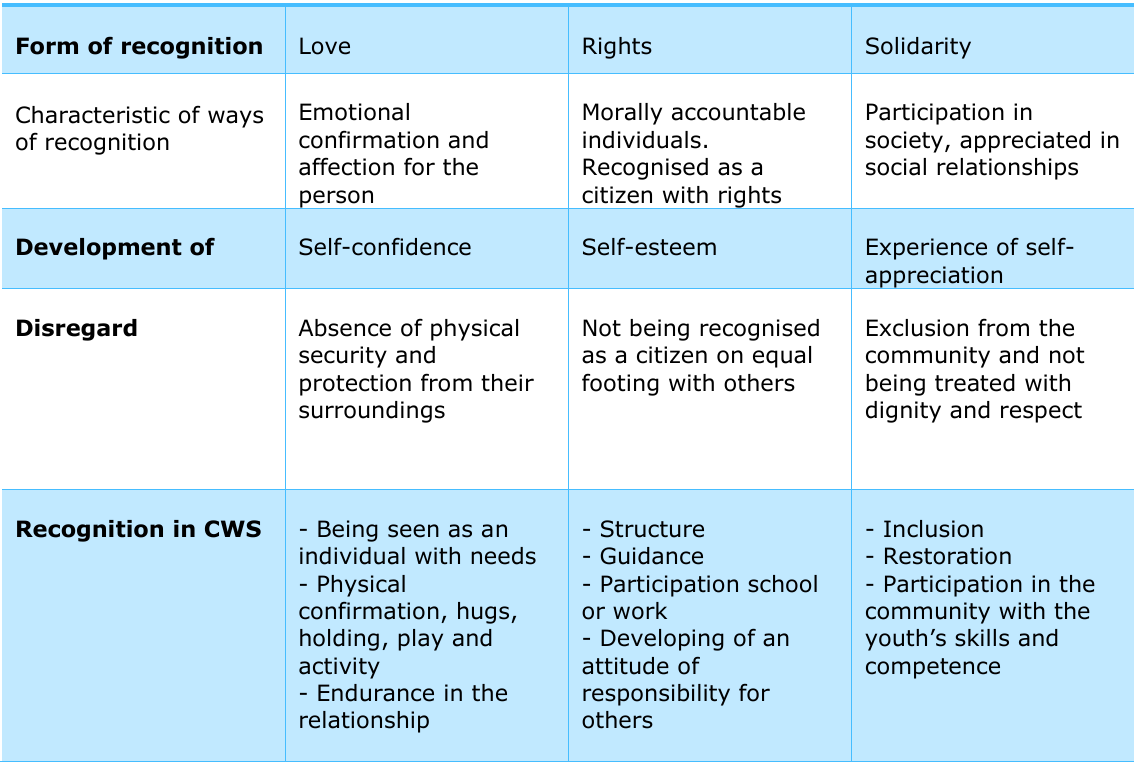
Figure 2. Honneth’s model of recognition and CWS follow- up programme with vulnerable youths. The figure shows the youth’s development based on the three forms of recognition, love, rights and